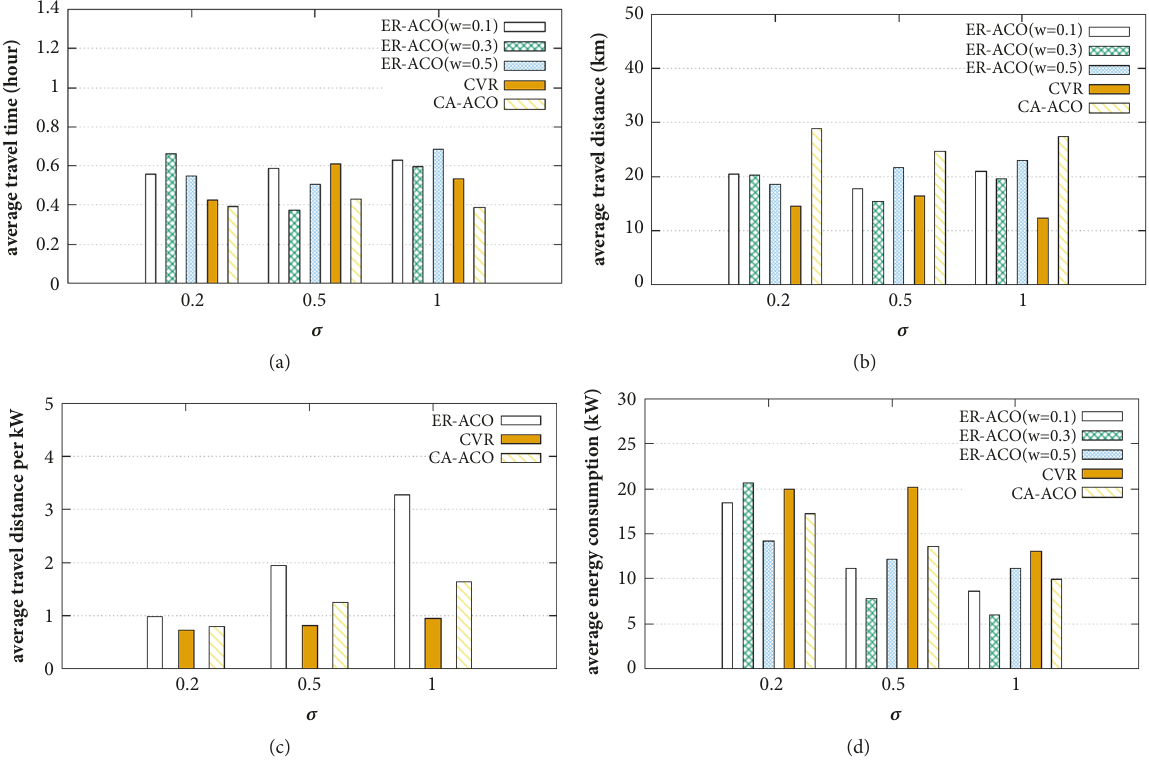
Figure 5: Performance comparison with varying gradients of the road in a uniform distribution: (a) travel time, (b) travel distance, (c) travel distance per energy consumption, and (d) energy